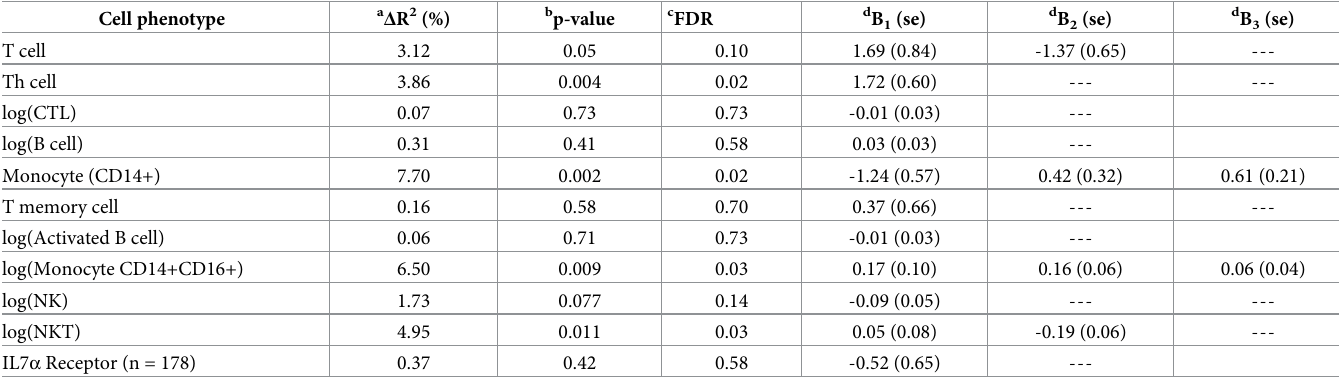
Table 2. Association between urinary arsenic concentration per creatinine (UAs/Cr) and immune cell phenotypes (n = 179). Cell